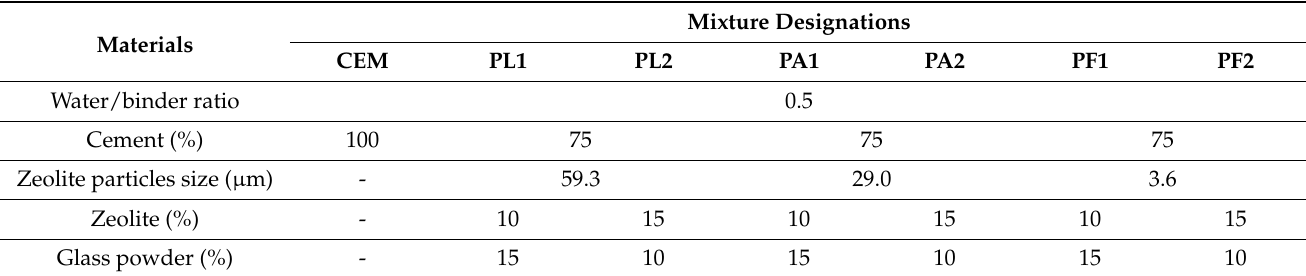
Table 5. Cement paste compositions.